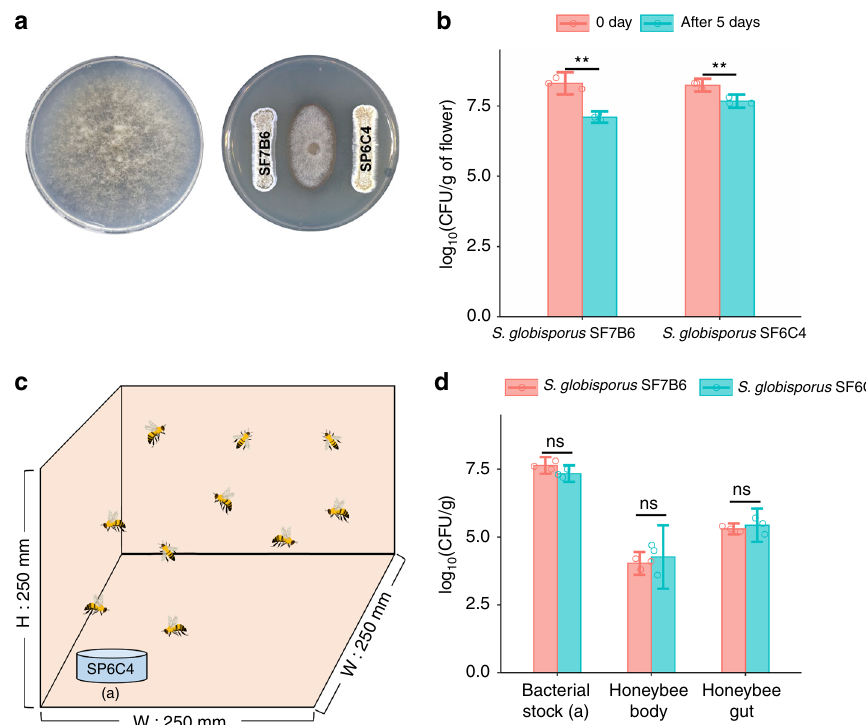
Fig. 3 SP6C4 antagonism in vitro against gray mold pathogen, colonization of the fl ower surface and the honeybee body. a Mycelium growth inhibition of Botrytis cinerea by strain SP6C4 and SF7B6 on PDK agar. Two strains were streaked on PDK agar with toothpicks. After 3 days, the pathogen agar block (0.7-mm) was placed at the center of the plate, then the plate was incubated for 7 days at 28 °C. b Flowers ( n = 3) received 100 μ L of the bacterial suspension (10 6 cfu/mL, 0.1% methyl cellulose). The fl owers were incubated in a growth chamber (16 h light, 28 °C; 8 h of dark, 24 °C). After 5 days, they were collected into 30 mL of PBS buffer and spread on PDK media with hygromycin (80 μ g/mL). Bars represent standard deviation (Paired sample t- test: SF 0 day vs SF after 5 days, P = 0.002854; SP 0 days vs SP after 5 days, P = 0.003858; ** P < 0.01). c Experimental illustration of SP6C4 colonization of the honeybee body and gut. d SP6C4 or SF7B6 (10 6 cfu/mL, 0.1% methyl cellulose) were introduced in a 5-cm Petri dish. After 5 days, bacterial population density was investigated both on the surface and in the gut of the honeybees. For honeybee surface colonization by the bacteria, the bodies were placed in 50 mL of PBS buffer and sonicated for 10 min. For gut samples, the bodies were rinsed three times with sterile water and gut tissue was extracted. The samples were diluted to 10 − 7 , spread on PDK agar with hygromycin (80 μ g/mL), the plate was incubated at 28 °C for 5 days and colony forming units were calculated. Differences in the bacterial colonization among the treatments were analyzed by independent two sample t -test (Bacterial stock: P = 0.007393, Honeybee body: P = 0.5705, Honeybee gut: P = 0.5355 and bars represent standard deviation. d Source data are provided as a Source Data fi